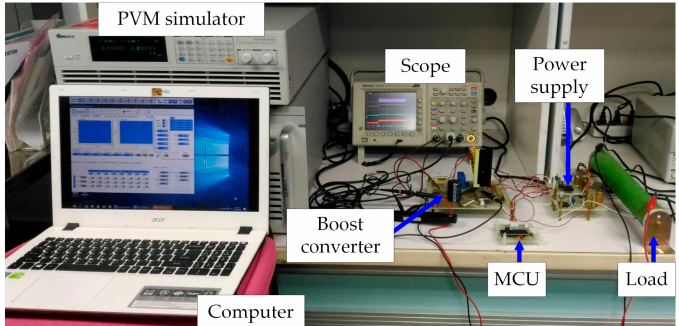
Figure 8. Experimental PVM and the proposed PVM-QR MPPT algorithm prototype test setup.